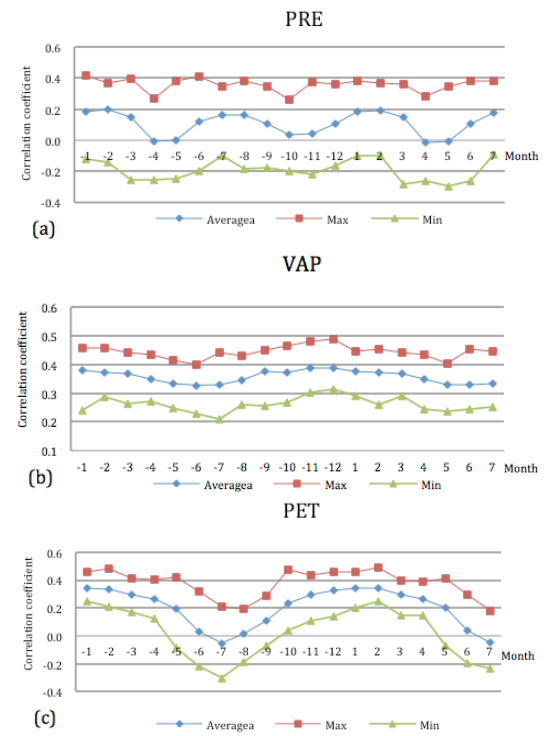
Figure 5. The max (red), mean (blue), and min (green) correlation coefficients for Red-bellied woodpecker, in terms